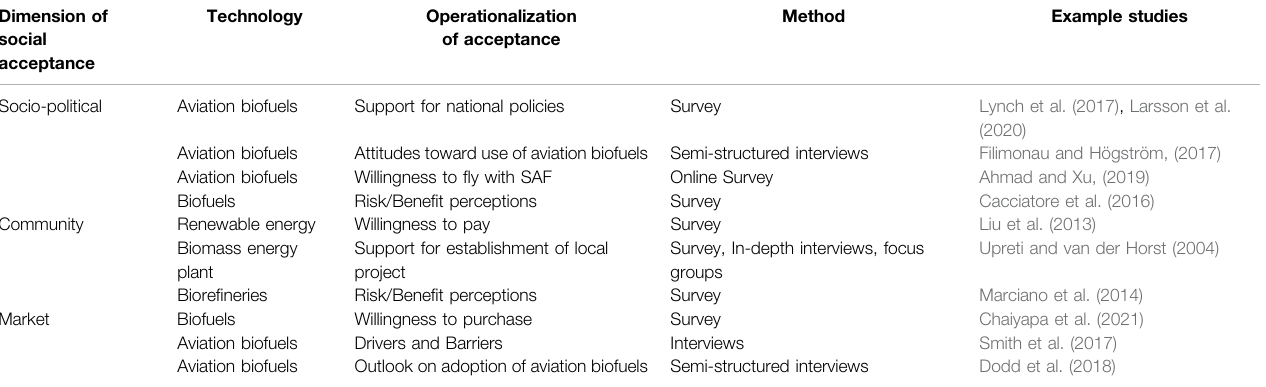
TABLE 1 | Overview of operationalization of public acceptance of (aviation)